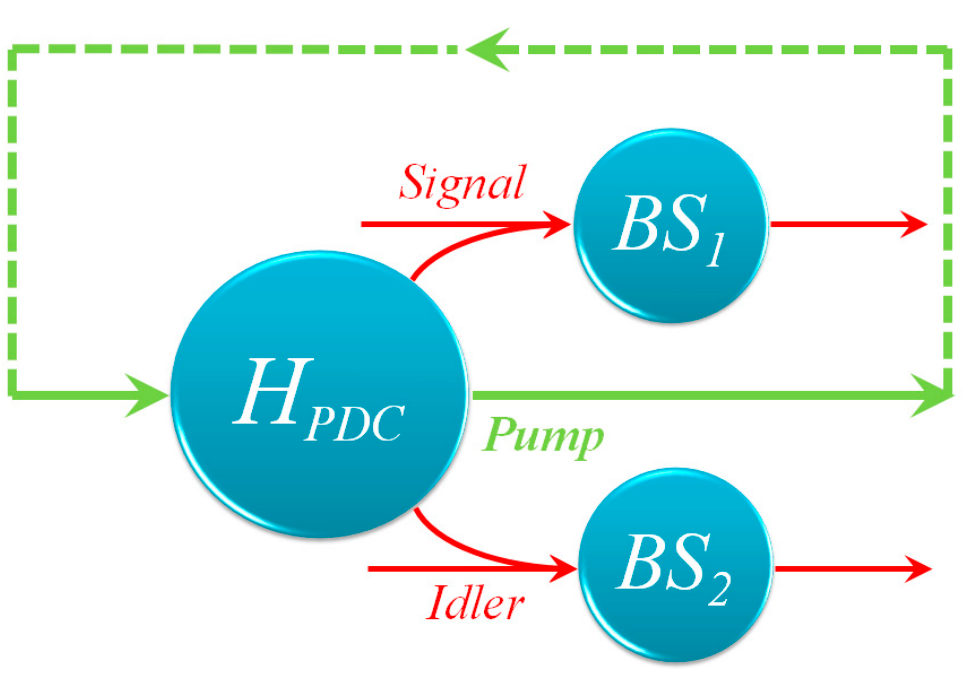
Figure 1. The illustration of a dz -cell. The local Hamiltonian describes the interaction of pump, signal and idler photons in nonlinear metamaterials, while the loss is represented by beam splitter transformation ( BS 1 and BS 2 ).